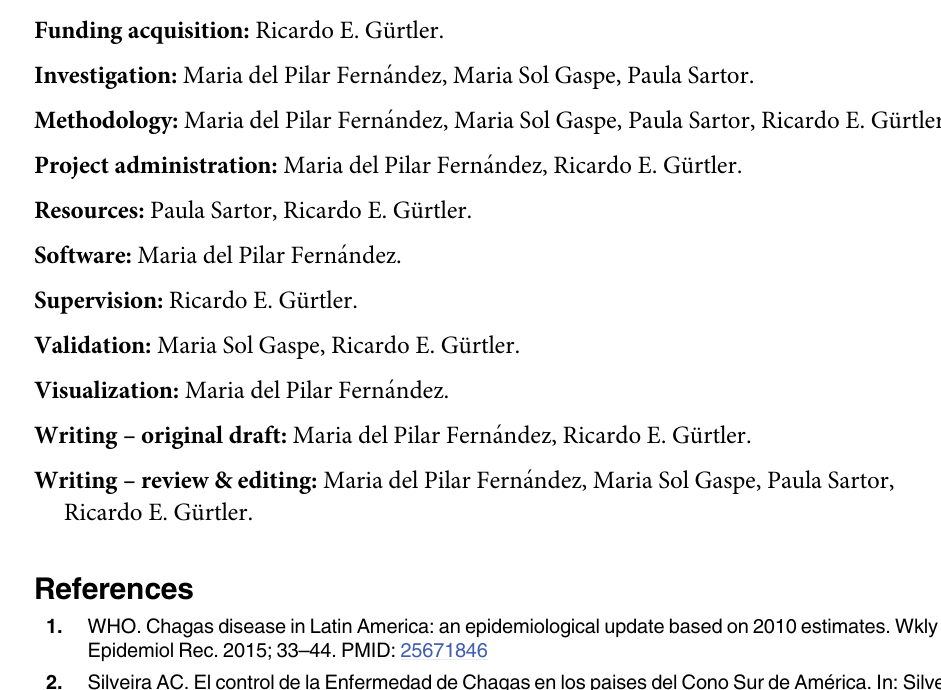
vs. the abundance of infected T . infestans (G). The lines with red dots indicate the observed values and the solid lines indicate the confidence ‘envelopes’. S6 Fig. Receiver operating characteristic curves (ROC) of the T . cruzi infection risk models for the total population (A) and children (B), with their respective the optimum threshold value for classification (i.e. maximizes sensitivity and specificity) and 95% confidence